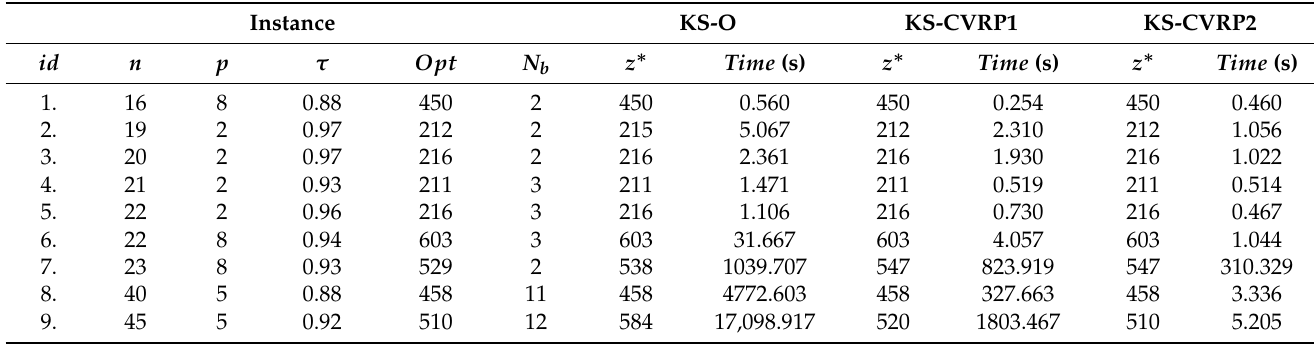
Table 1. Comparison of computational times.